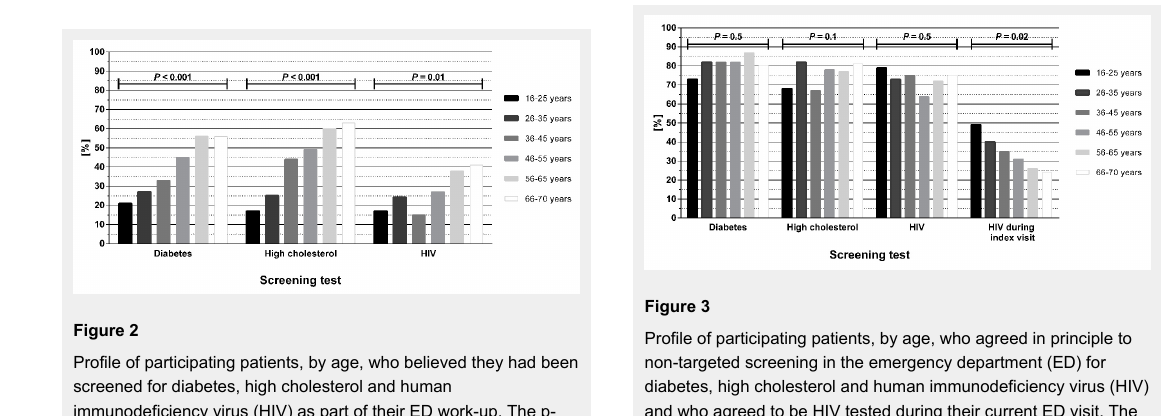
Table 2: Breakdown by age category of all the patients aged 16 to 70 years old who attended the ED during the study period and those who were included in the study. Age category All patients presenting to ED Percentage of all patients by (years) (n = 15 052) age category *